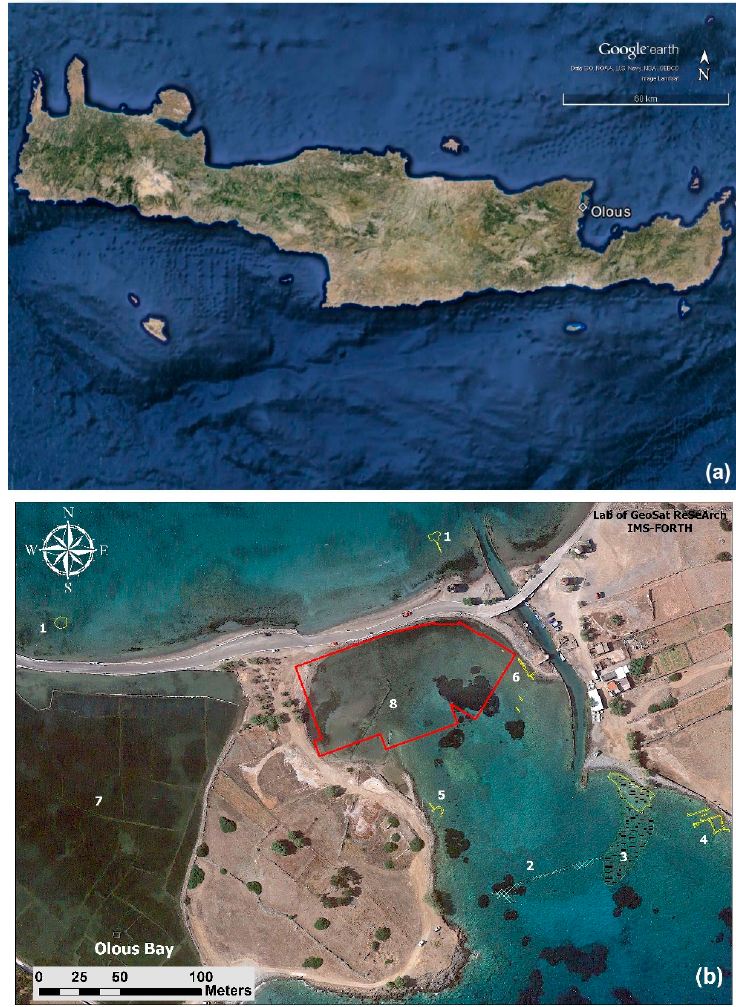
Figure 1. ( a ) Landsat satellite image of Crete showing the location of the submerged archaeological site of Olous; ( b ) Detail of the area that was surveyed in Olous in January 2016 (in red) along with the visible archaeological submerged features (in yellow). (1) Fortified towers; (2) fortification wall; (3) tier; (4) building complex; (5) basilica; (6) walls; (7) salt pans; (8) area covered by the project.